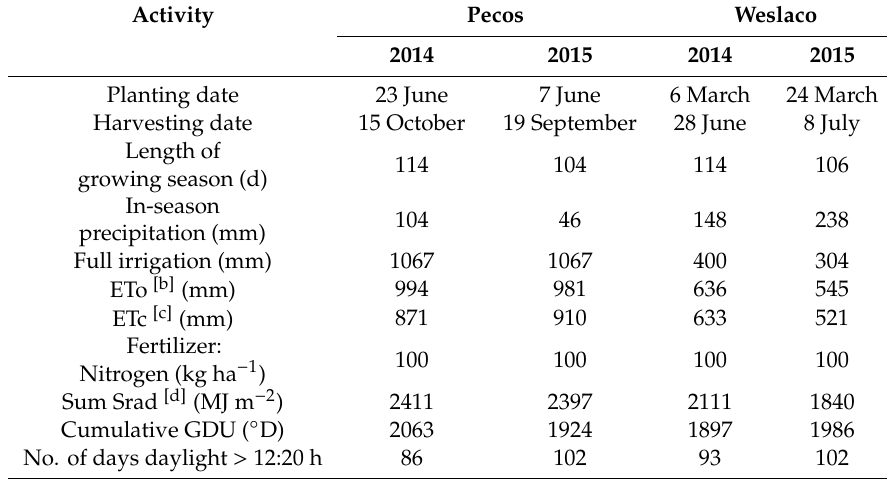
Table 2. Agronomic and irrigation data for energy sorghum at Pecos, TX and Weslaco, TX.